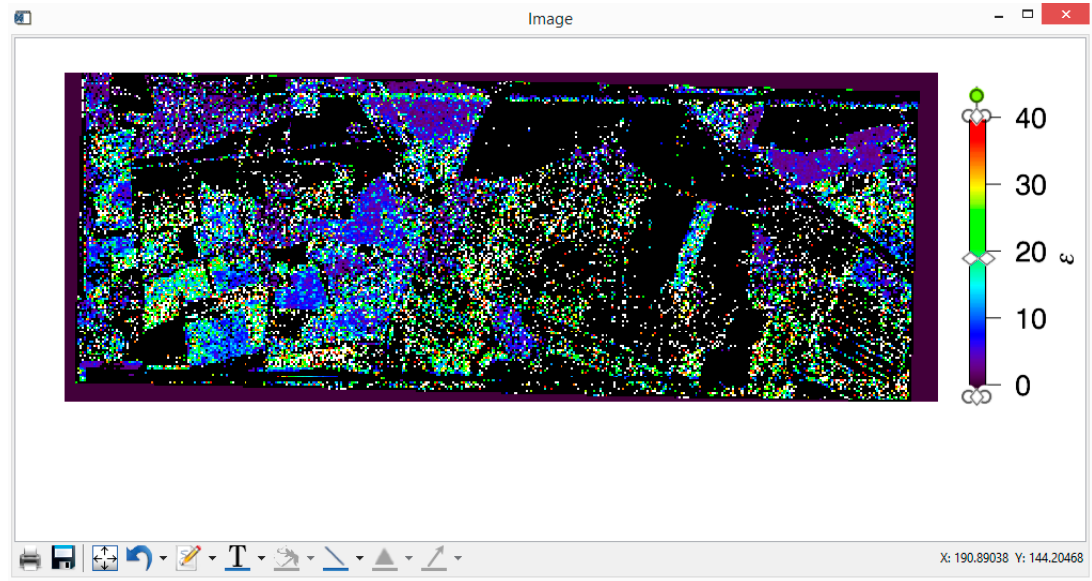
Figure 10. PTSM’s retrieval of dielectric constant ε for the Demmin area (16 May 2006). North is the top of the image, east is on the right.